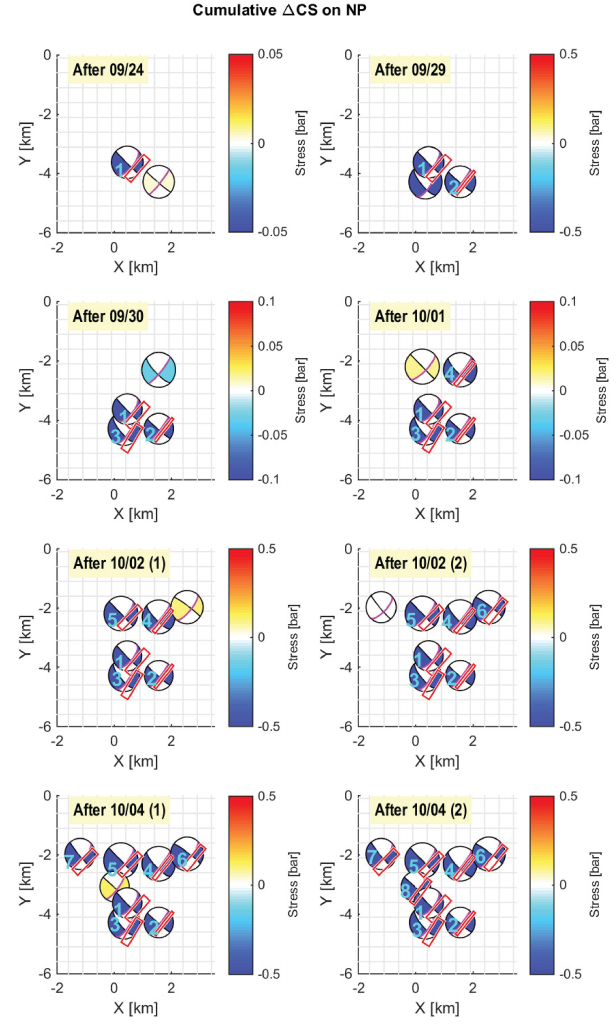
Figure D1. Cumulative Coulomb stress changes resolved on the nodal planes as obtained just before slip of each one. Each subplot shows the FM solution with cumulative (cid:49) CS values on both the NP(s) of the old and the upcoming event. Past NPs are shown as red rectangles (faults with slip). Note that the color bar scale saturation changes as the sequence